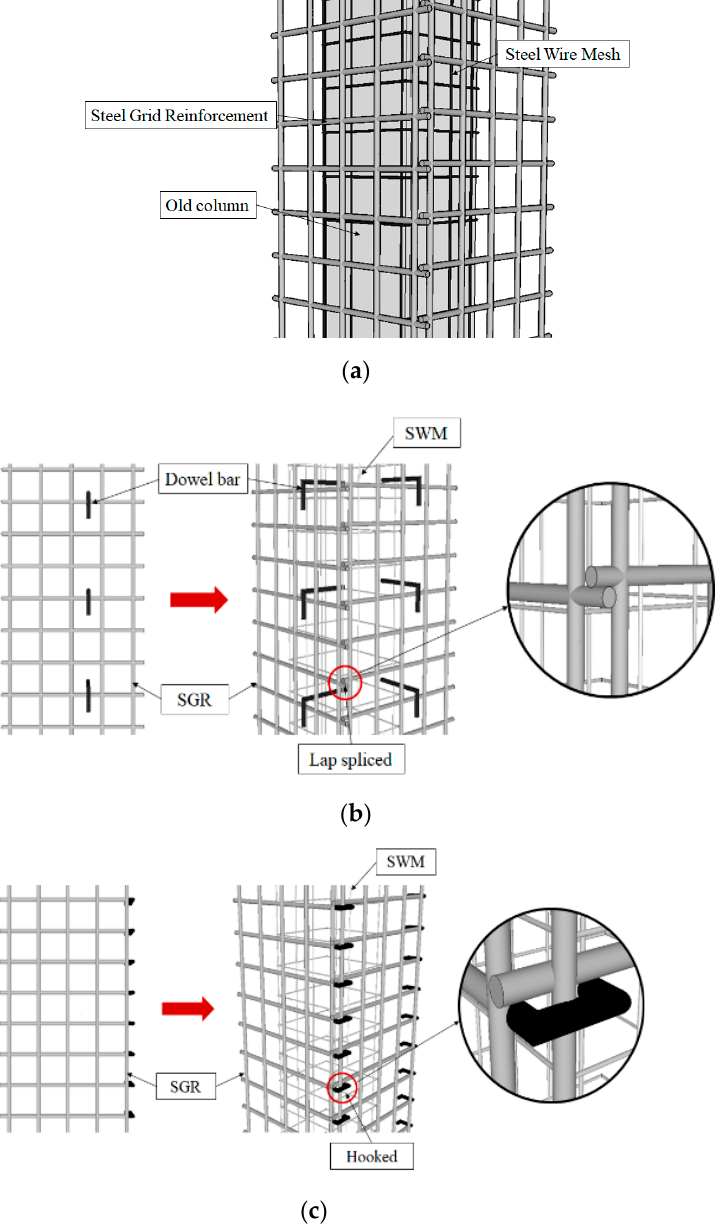
Figure 1. Proposed details of the concrete jackets: ( a ) A combination of SWM and SGR; ( b ) Type 1; ( c ) Type 2.